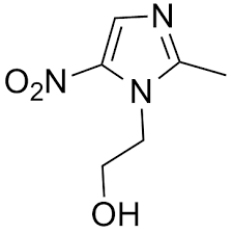
Figure 1. Molecular structure of metronidazole